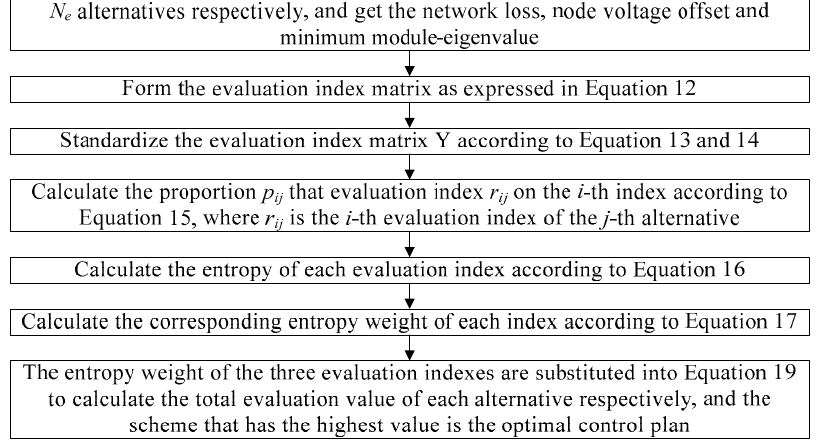
Figure 4. Flow chart of reactive power optimization in distribution network based on entropy-weight method.